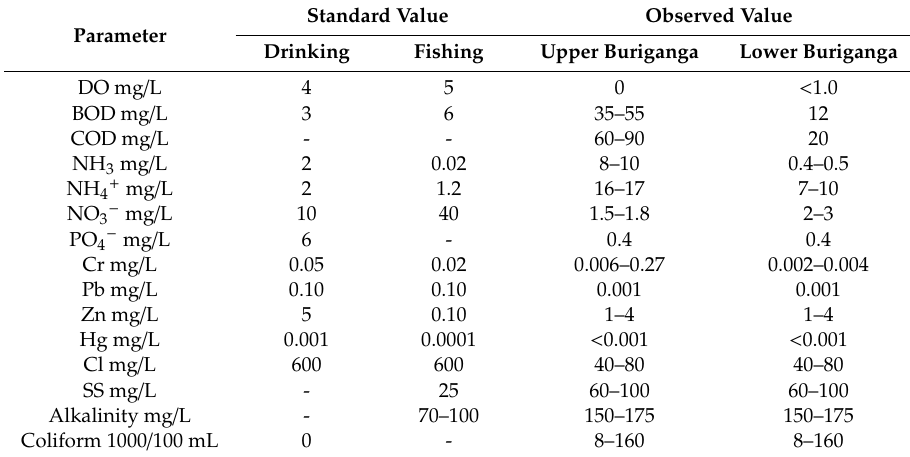
Table 2. Water quality standard of the Buriganga